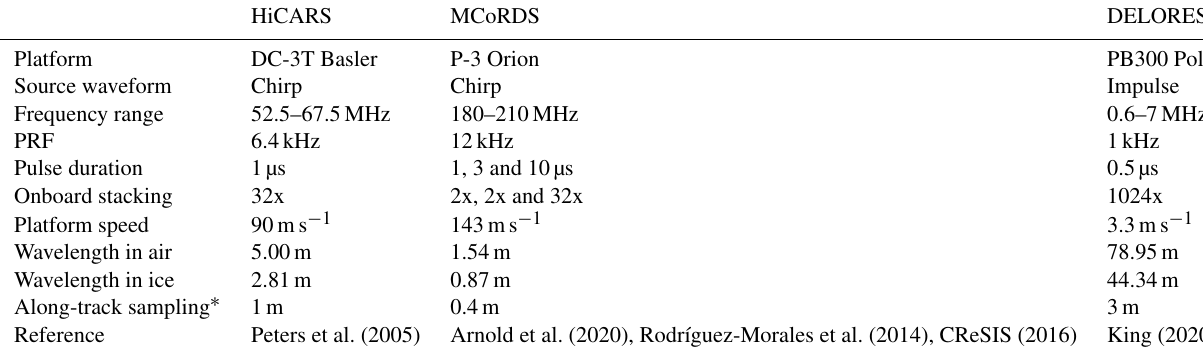
Table 1. Ice-penetrating radar system characteristics before focusing and migration.